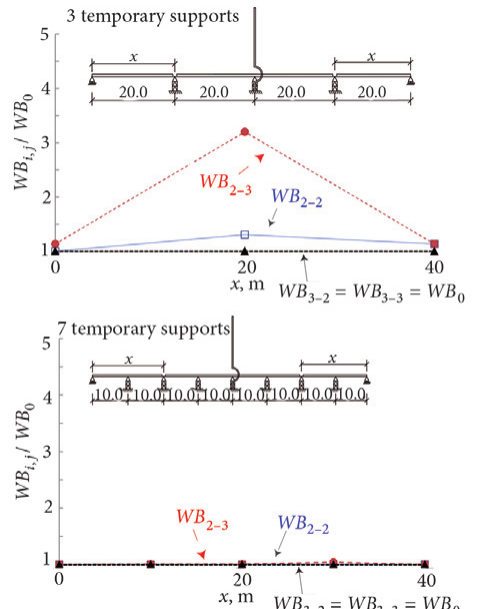
Fig. 6. Ratio between the bending energy of a structure with stays and construction joints and the bending energy of the equivalent continuous beam for different locations of the construction joints and number of temporary